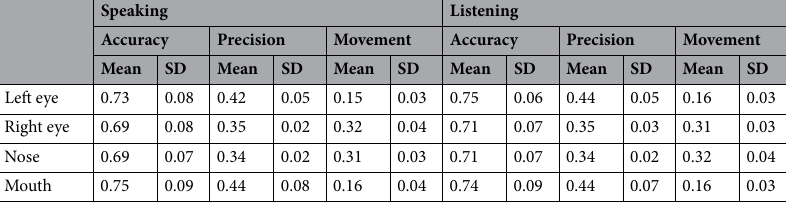
Table 4. Precision, accuracy and movement during the face-to-face conversation. Values are reported in degrees visual angle (°) as a function of the participants’ speaking and listening phases. Precision = standard deviation of data samples (Holmqvist et al.,